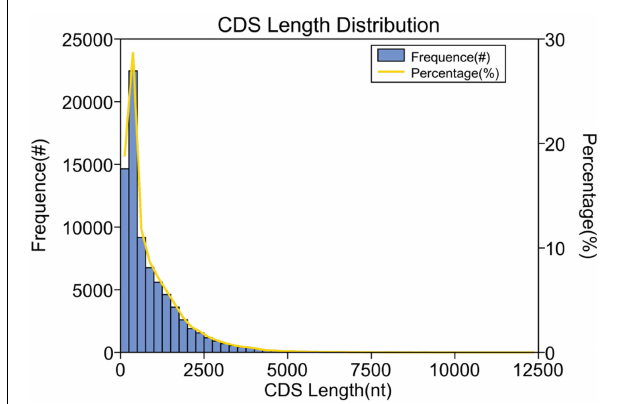
FIGURE 6 | Length distribution of the coding sequences ( n = 4). The x -axis represents the coding sequence length and the y -axis represents the number of predicted coding sequences.